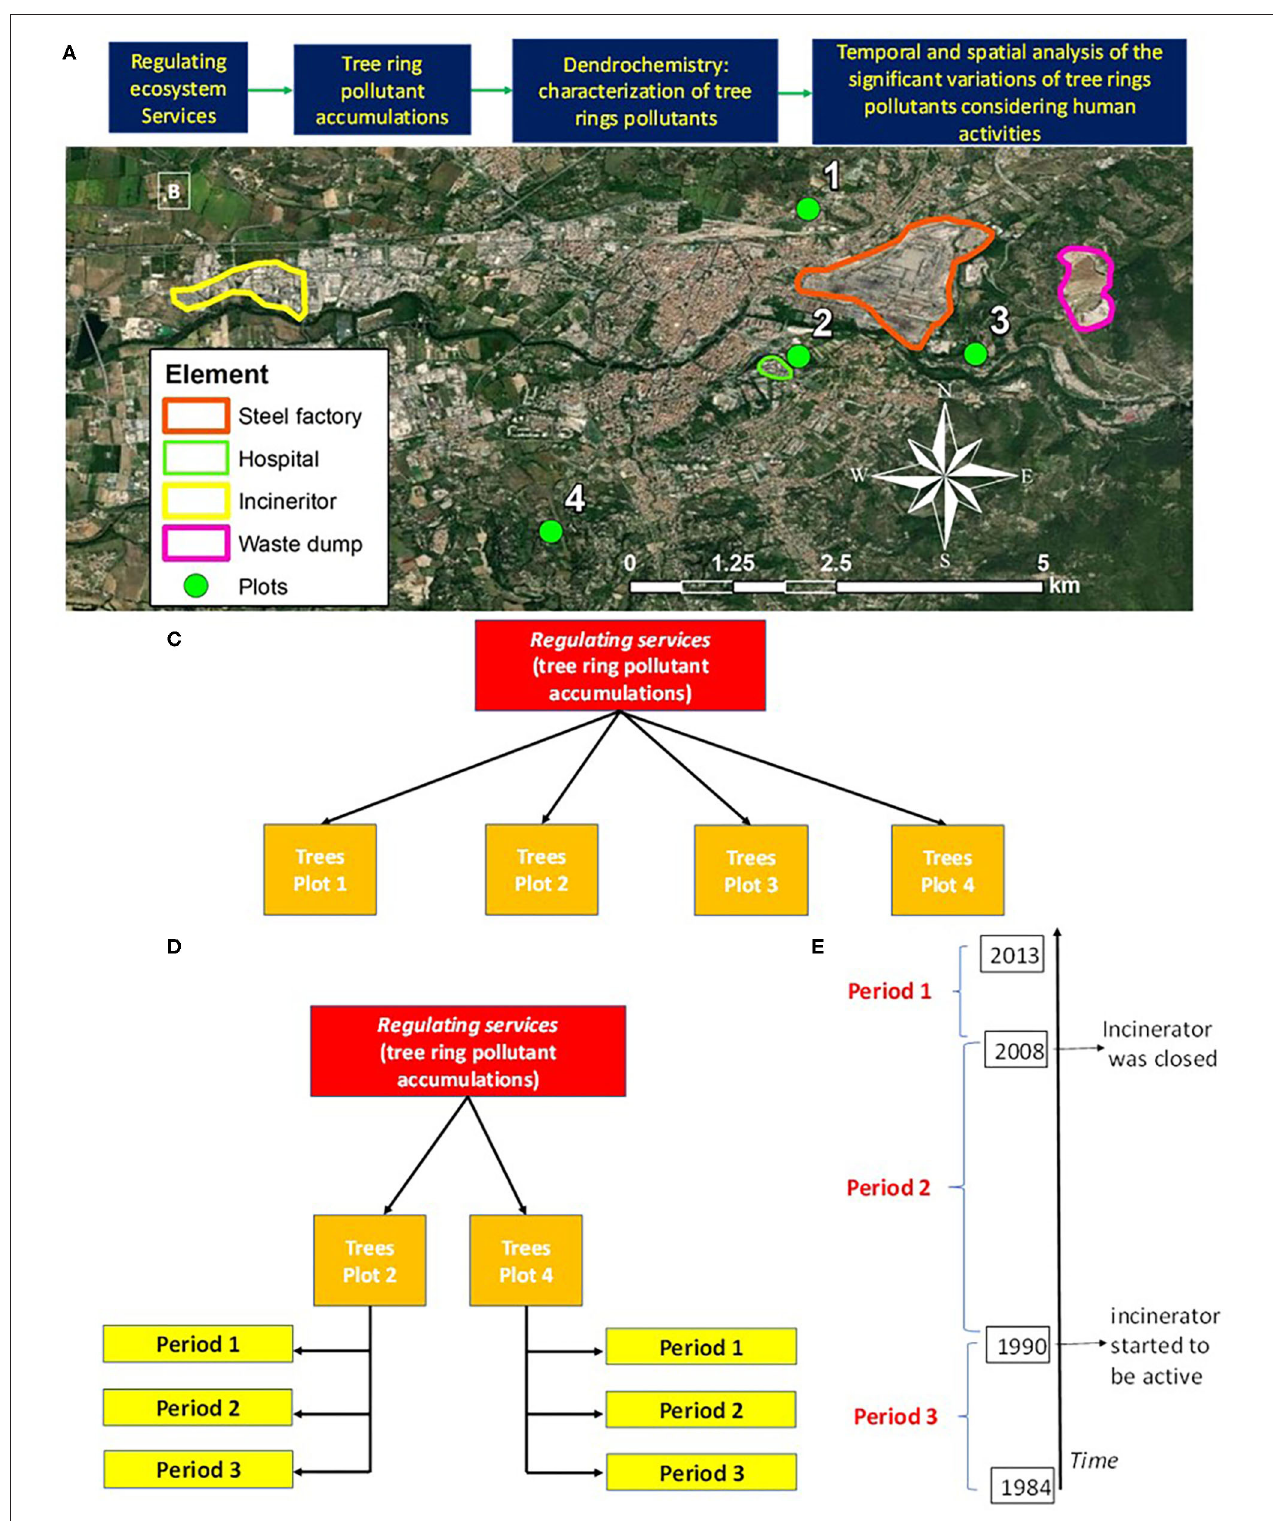
FIGURE 1 | Conceptual model of the definition of pollutants’ levels in tree rings in urban area (A) ; location of sampling plots (B) ; assessment of the pollutant level in plots 1, 2, 3, 4 (C) ; assessment of the pollutant’s levels in different periods in plot 2 and plot 4 (D) ; details of industrial history in the study area (E) .